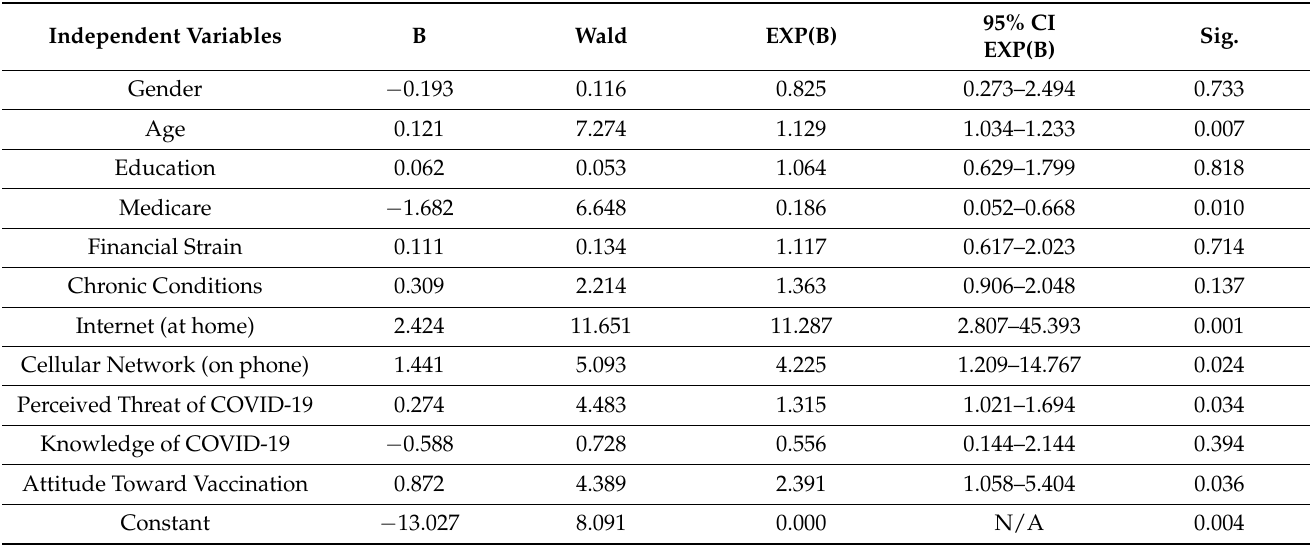
Table 3. Binary Logistic Regression, EXP(B) the exponentiation of the B coefficient (odds ratio and 95% confidence interval